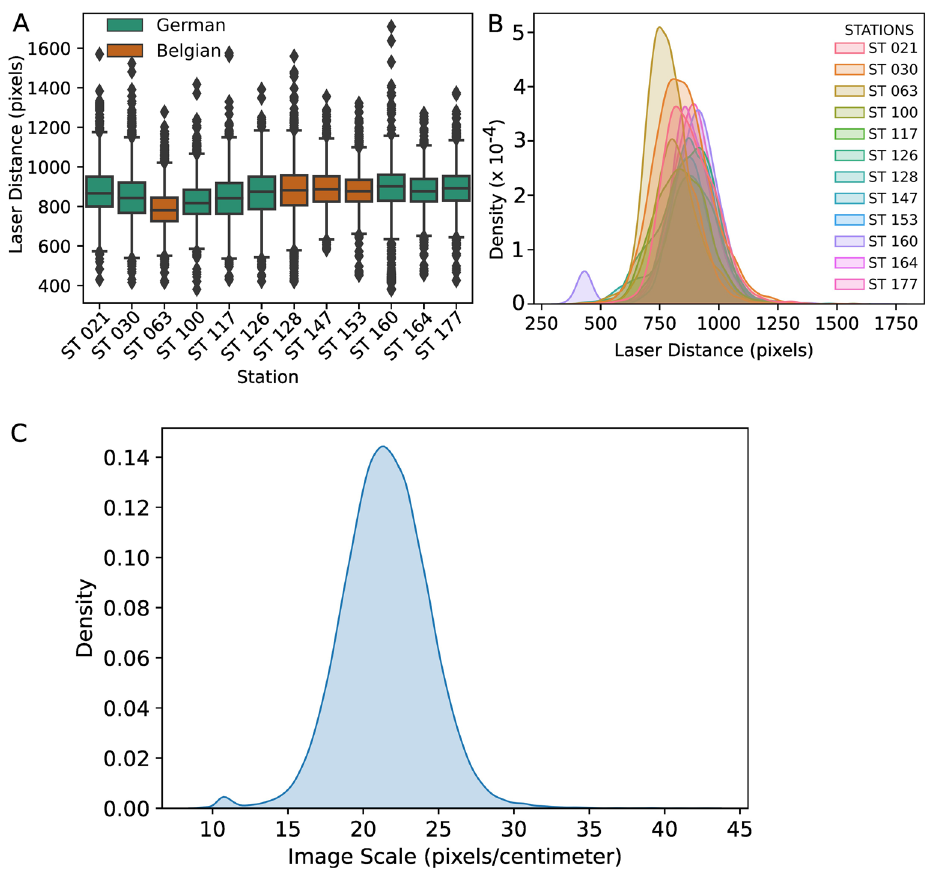
Figure 1. Distribution of detected laser point separation distance in pixels. These are grouped by dive station and represented as ( A ) box plot with whiskers, and ( B ) normalized kernel density estimate. ( C ) Distribution of image scale in pixels/centimeter obtained by scaling the detected laser distance by known